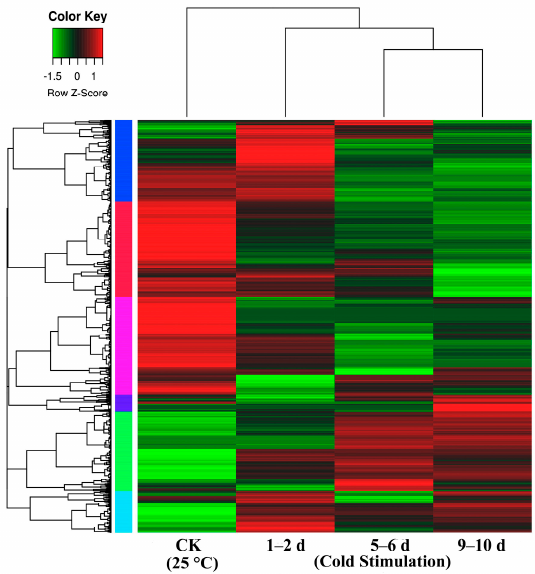
Figure 3. Heat map representation of cluster analysis for the expression patterns of over 7000 differential gene expressions (DEGs) ( p value: < 0.05, fold change: ≥ 2 fold (log2 |FC > 1|)) between control (CK = 25 °C) and different stages of cold stimulation ( − 3 °C for a duration of 1–2 d, 5–6 d, and 9–10 d) using the FPKM. The samples of the three stages of cold stimulation cluster together; notably, the 5–6 d and 9–10 d samples cluster particularly close.